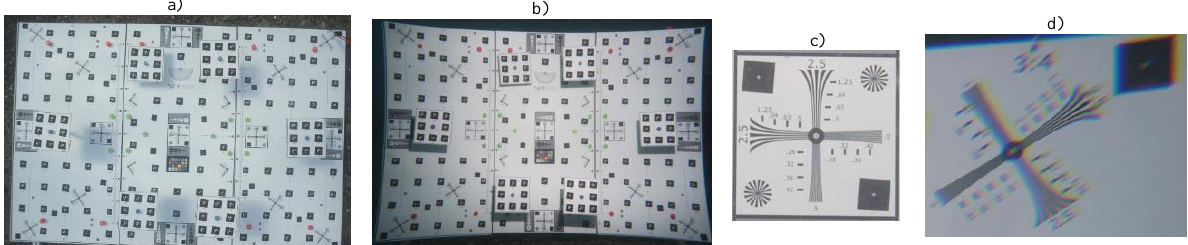
Figure 6. Portable testfield underwater as imaged by the dome port (a) and flat port (b). Enlarged views of the image taken with the flat port at the centre (c) and at the up right corner (d) of the testfield.